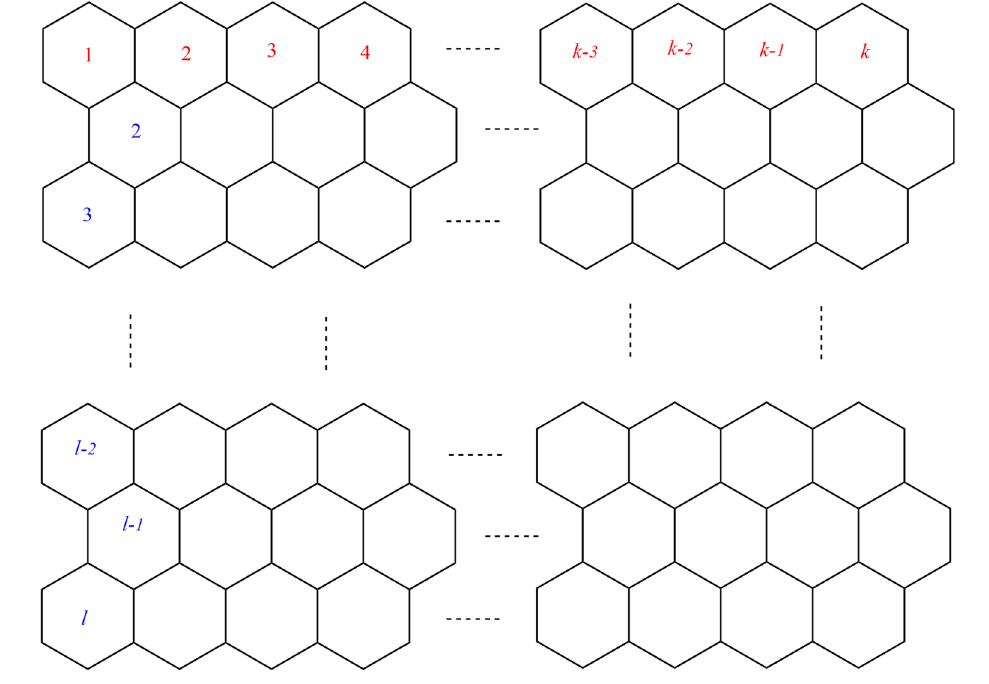
Figure 5. Graphene structure with 𝑙 > 1, 𝑘 > 1 .